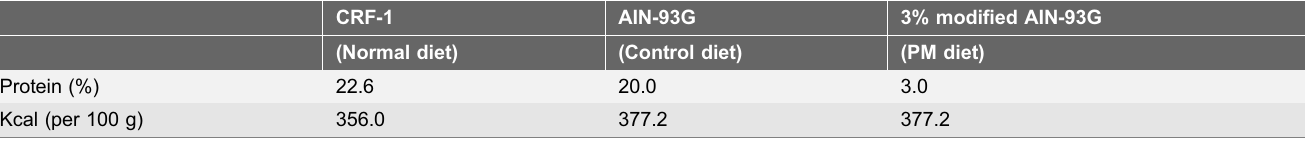
Table 1. Diet composition.